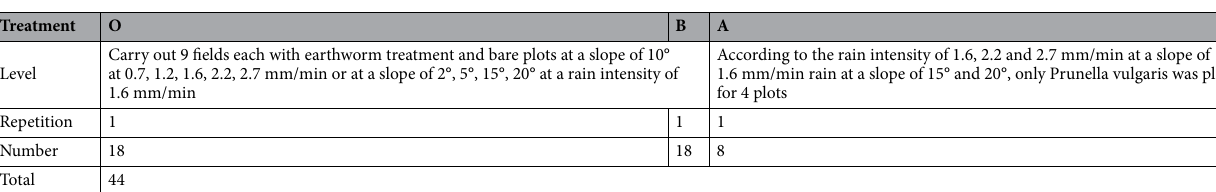
Table 1. Field simulation rainfall test design and times. The significance level of the equation is 0.05. O is bare slope, B is Prunella vulgaris combined with earthworm planting slope, A is Single planting prunella vulgaris slope.